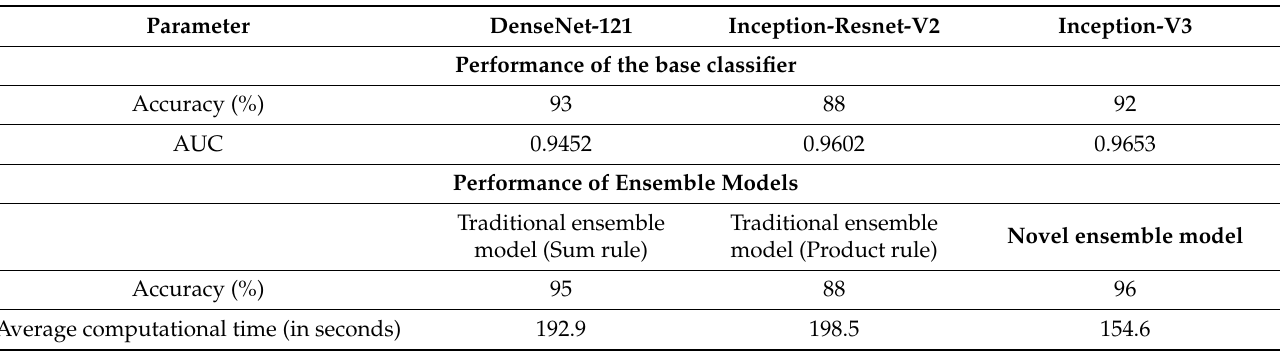
Table 4. Comparative performance of the